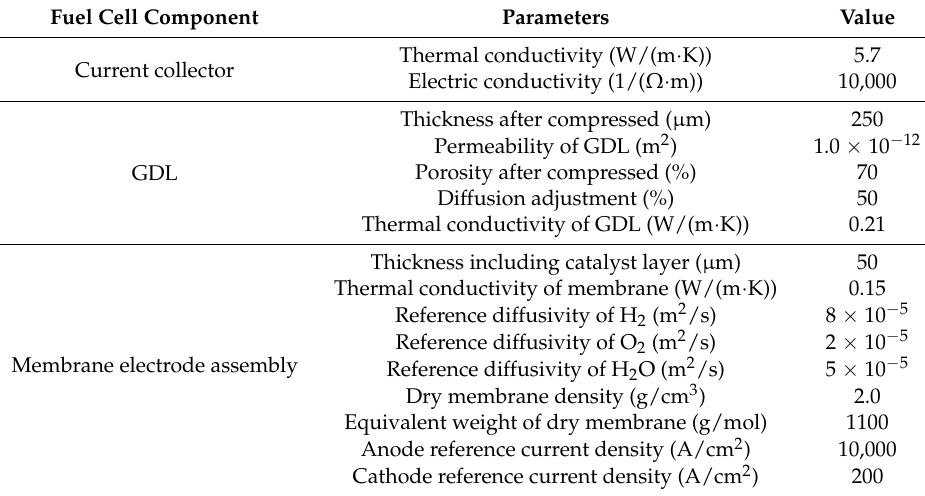
Table 3. Details of the parameters and properties used in this simulation